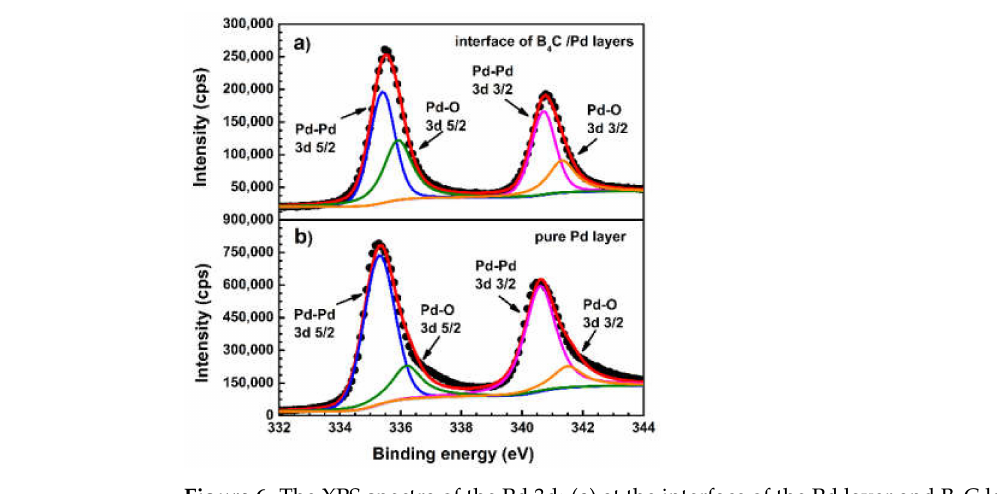
Figure 6. The XPS spectra of the Pd 3d: ( a ) at the interface of the Pd layer and B 4 C layer placed in the dry oxygen-rich environment; and ( b ) pure Pd layer.